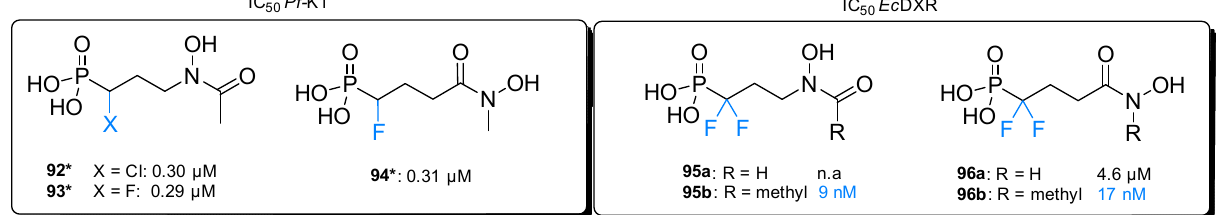
Figure 20. Biological activities of α -halogenated phosphonic acid derivatives ( 92 – 96 ). * Ammonium salts were